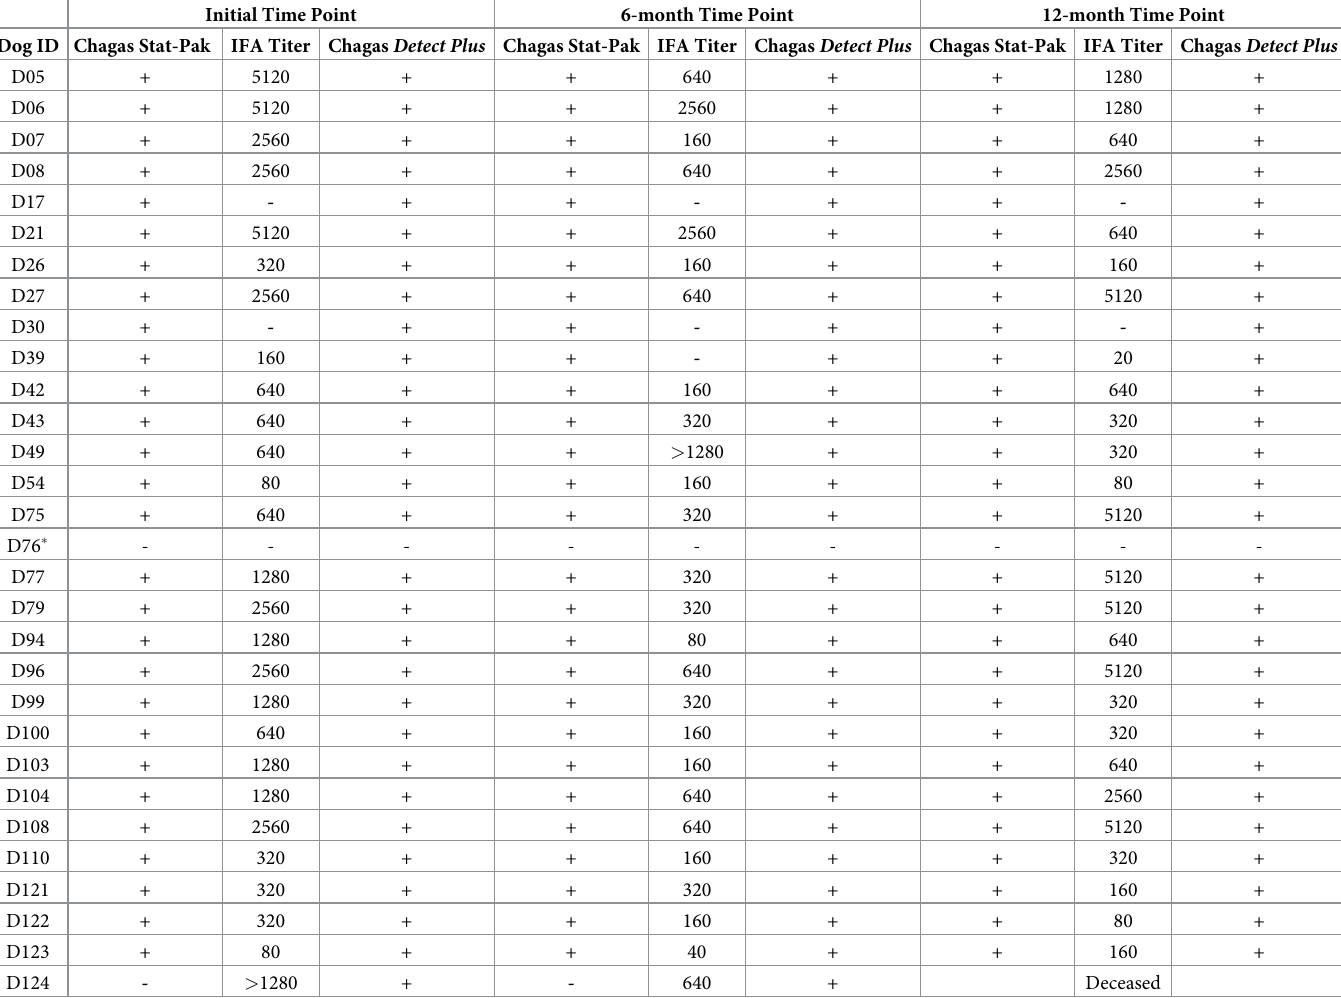
Table 2. Serology of the 30 dogs enrolled as T . cruzi- positive in the study. The two rapid tests (Chagas Stat-Pak and Chagas Detect Plus ) are scored as Positive (“+”) or Negative (“-”), and the IFA titer is reported in which a result of < 20 is noted as Negative (“-”). Initial Time